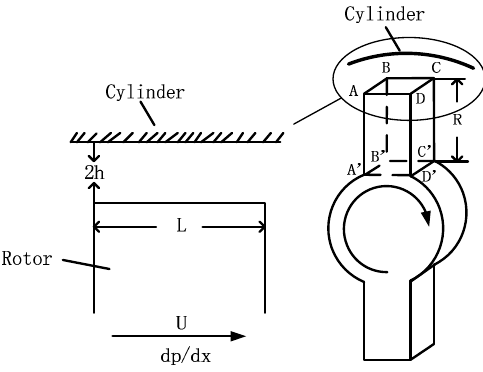
Figure 7. Schematic of the leakage model.